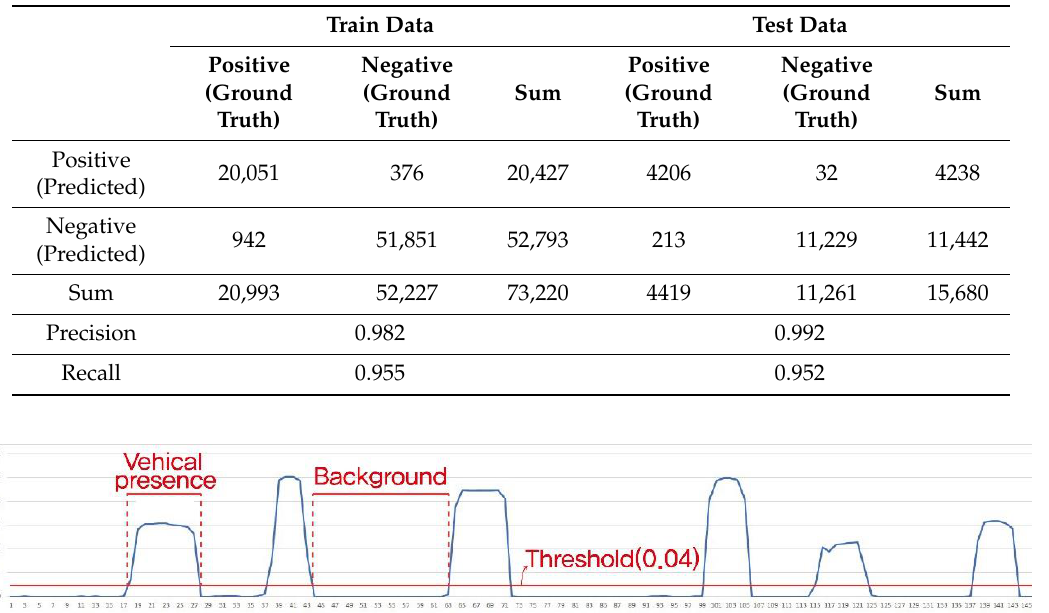
Table 3. The precision and recall of the autoencoder when synthesized images are used as input.